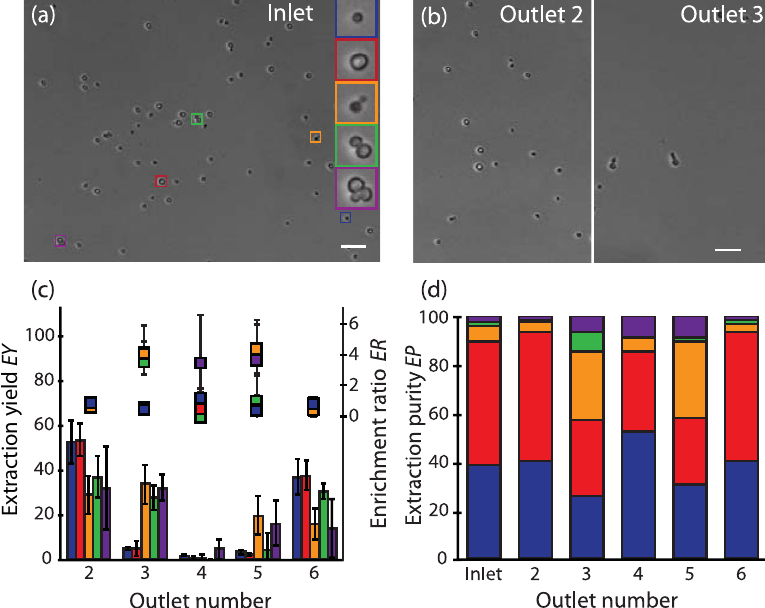
¼ 0 : 64 , seven outlets with (cid:5) ¼ 3 = 4 , (cid:5) ¼ 1 = 2 , (cid:5) ¼ 1 = 4 ) at 60 (cid:1) L = min . FIG. 6. Yeast-cell sorting in SAPS device C ( AR c 1:2 1:3 1:4 (a) A picture of the cells in the inlet. Cells are categorized into five groups: small single (blue), large single (red), budded (orange), doublet (green), and aggregate (purple). (b) Singles have a high extraction yield in outlet 2, while in outlet 3, the purity of budded cells increases. (c) The collected ratio of particles is shown at each outlet, considering the extraction yield EY and enrichment ratio ER and (d) extraction purity EP . Each value shows the mean (cid:4) SD from three independent experiments. Since no particles were captured from outlets O1 and O7, only the collected ratio of particles at outlets O2 to O6 appear in the